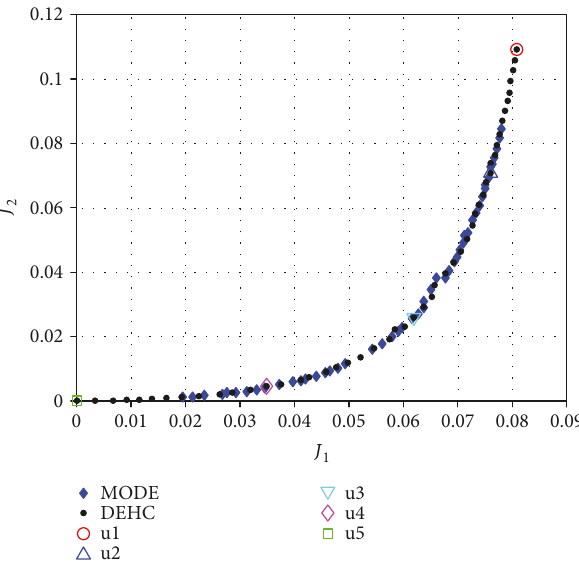
Figure 14: The Pareto optimal front for case II.